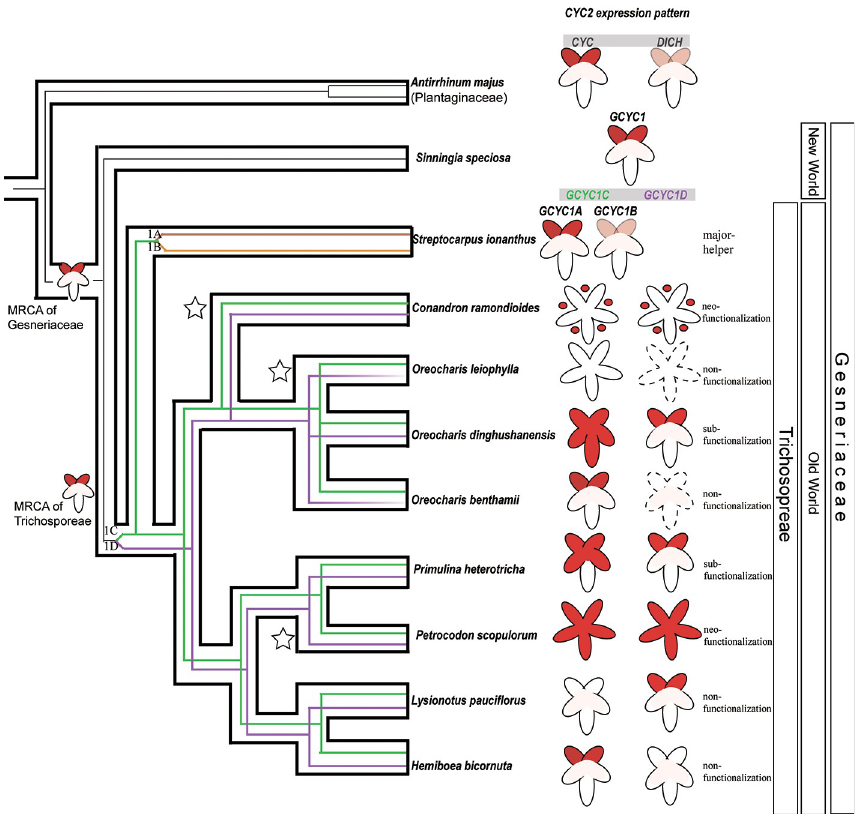
Fig 6. Reconstructed ECE -CYC2 evolution emphasizing shifts of GCYC expression pattern after gene duplication in correlation to floral symmetry transitions among selected Asiatic Trichosporeae species.